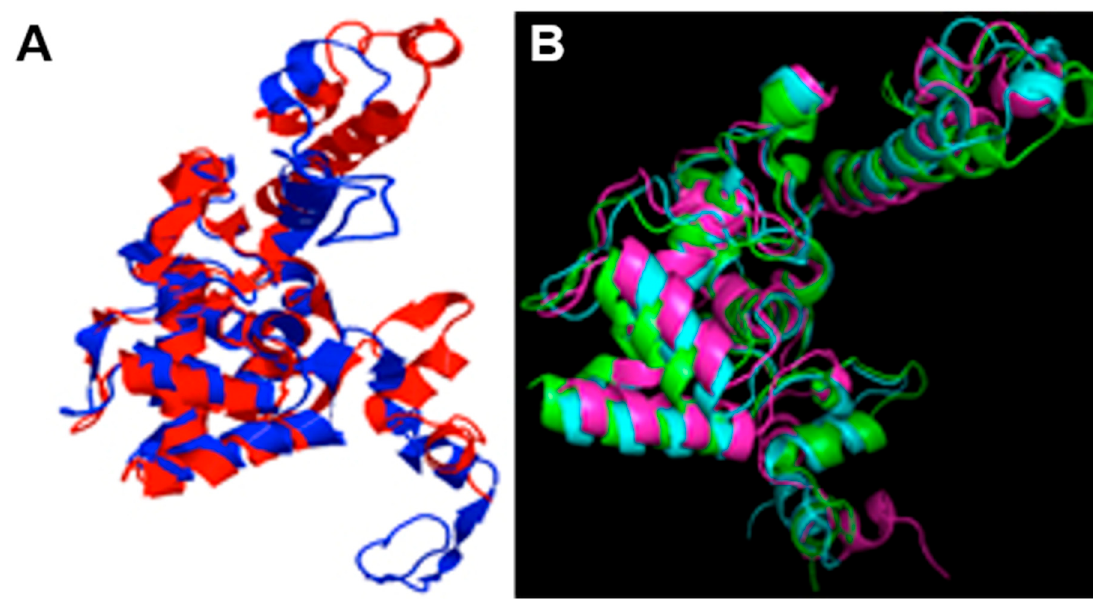
Figure 4. ( A ) Original model of the babaco mosaic virus coat protein (red), built with the I-TASSER homology modeling algorithm, superposed to a representative structure after 50 ns of molecular dynamics simulation (blue). The TM score between both models is 0.67830. ( B ) Superposition of the representative structure of the main clusters of molecular dynamics simulation during 50 ns where the inherent flexibility of the coat protein is visible. Each color represents one of the cluster-representative structures. Only three models are shown.